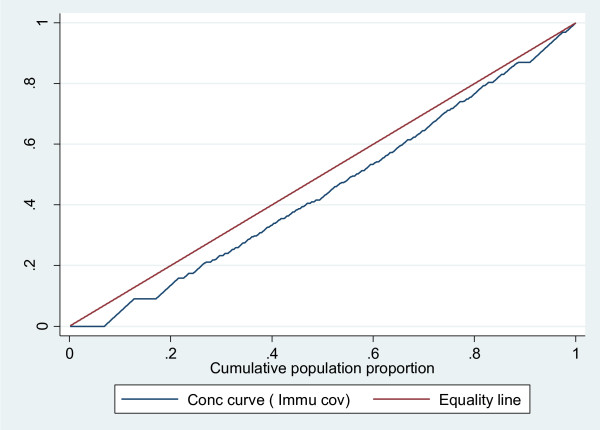
Concentration curve for Immunisation coverage.